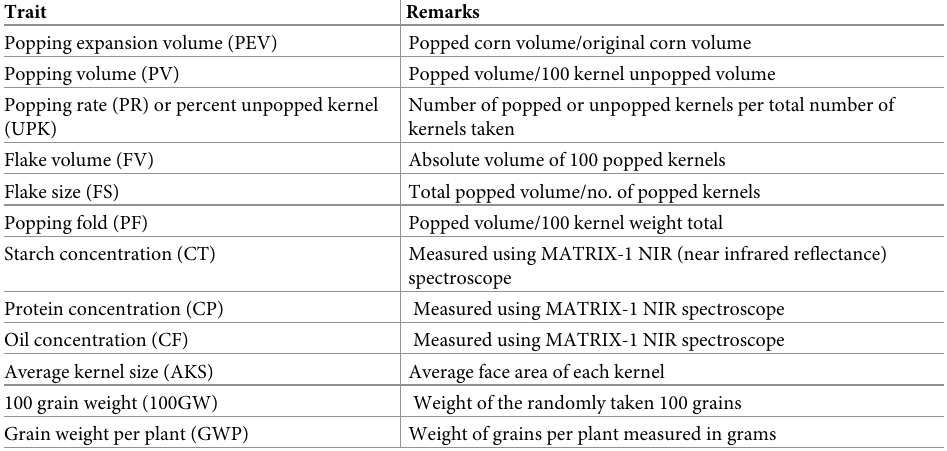
Table 1. Popping related traits and their details commonly used in popocorn breeding with abbreviations used in the